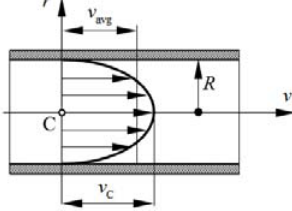
v for circular avg